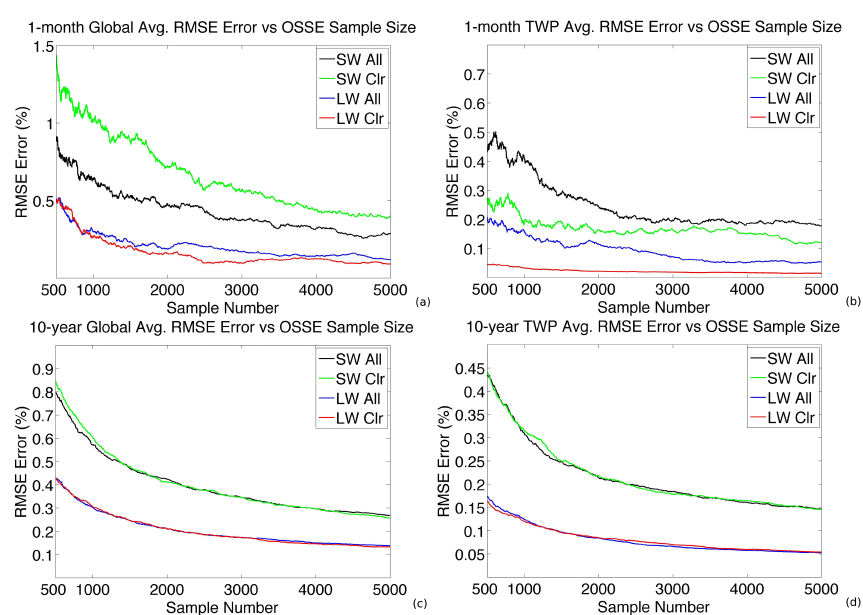
Figure 5. (a) RMSE vs. number of randomly sampled grid cells for January 2000 global average. (b) Same as (a) but for a tropical western Pacific region (10 ◦ S–10 ◦ N, 100–150 ◦ E). (c) Same as (a) but for decadal average 2000–2009. (d) Same as (b) but for the decadal average